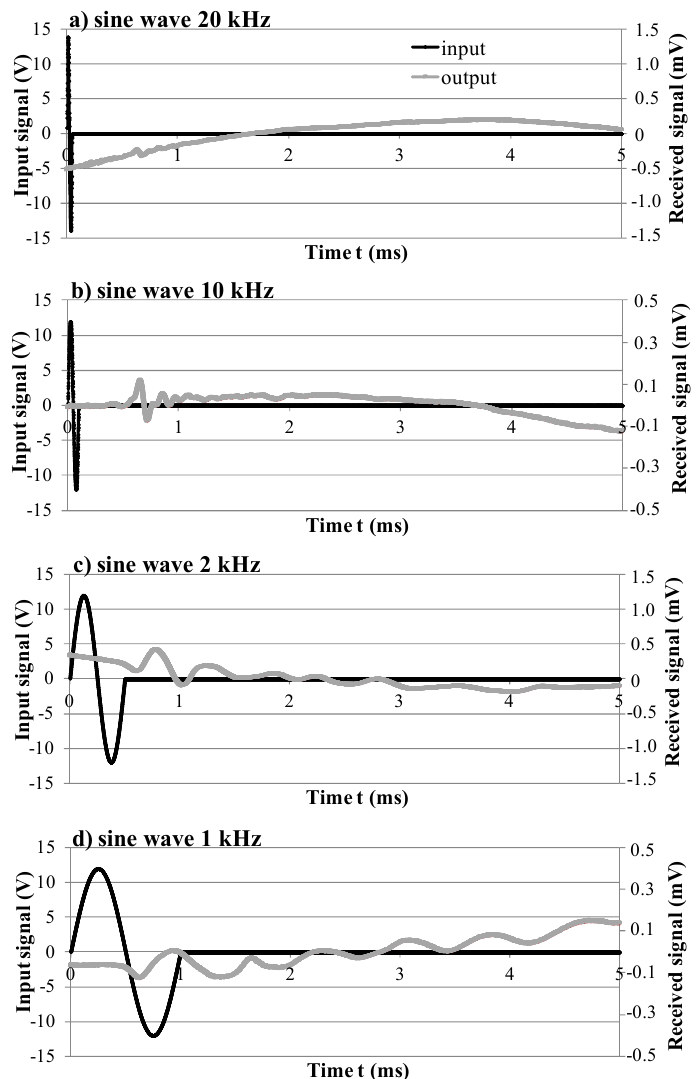
Figure 7. The oscilloscope signals at various frequencies of input signals: ( a ) 20 kHz, ( b ) 10 kHz, ( c ) 2 kHz, ( d ) 1 kHz and at the same effective stress value.